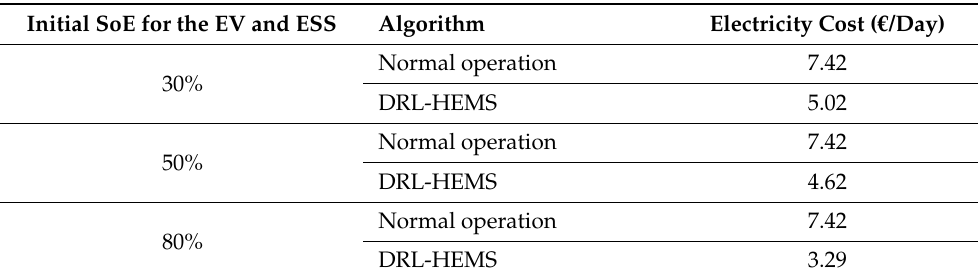
Table 8. The total operational electricity cost for different SoE values for one day. Initial SoE for the EV and